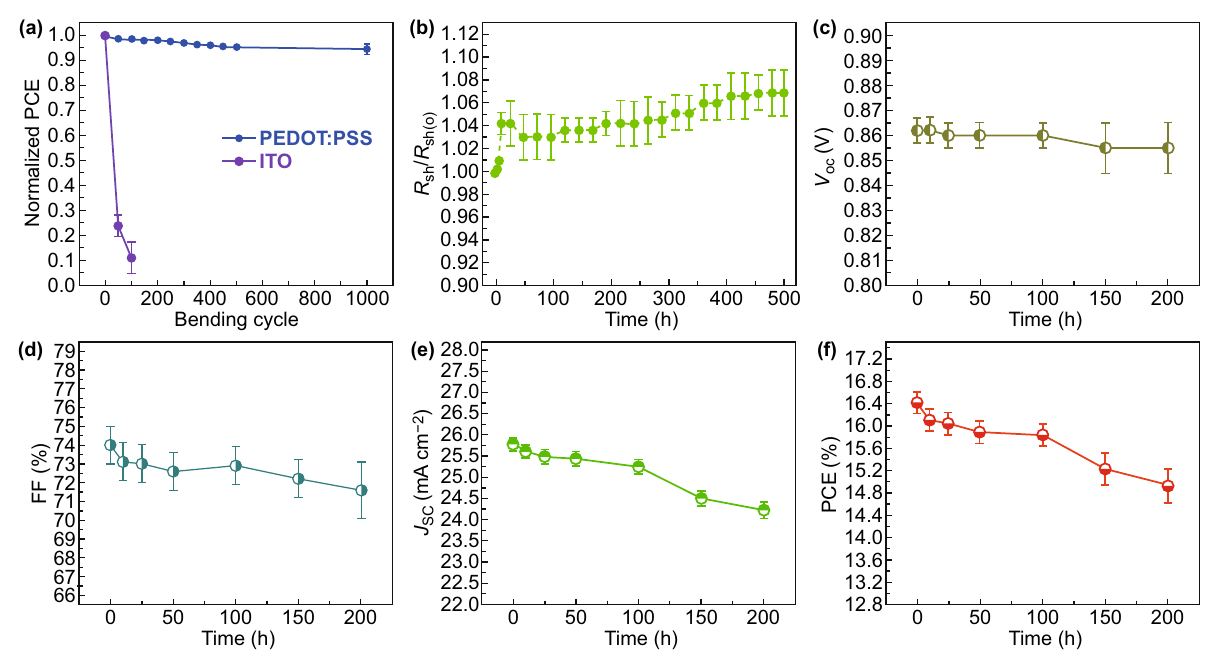
Fig. 6 Mechanical property and thermal stability of the flexible OSCs. a Profiles of normalized PCE of flexible OSCs based on the CF 3 SO 3 H-doped anodes and ITO in harsh flexing tests at r of 1.50 mm. b R sh versus the thermal processing time for the CF 3 SO 3 H-doped PEDOT:PSS anodes under 85 °C/85% relative humidity conditions. Profiles of photovoltaic parameters of the flexible OSCs based on the 0.8 M CF 3 SO 3 H-doped anodes as a function of the thermal processing time: c V OC , d FF, e J SC , and f